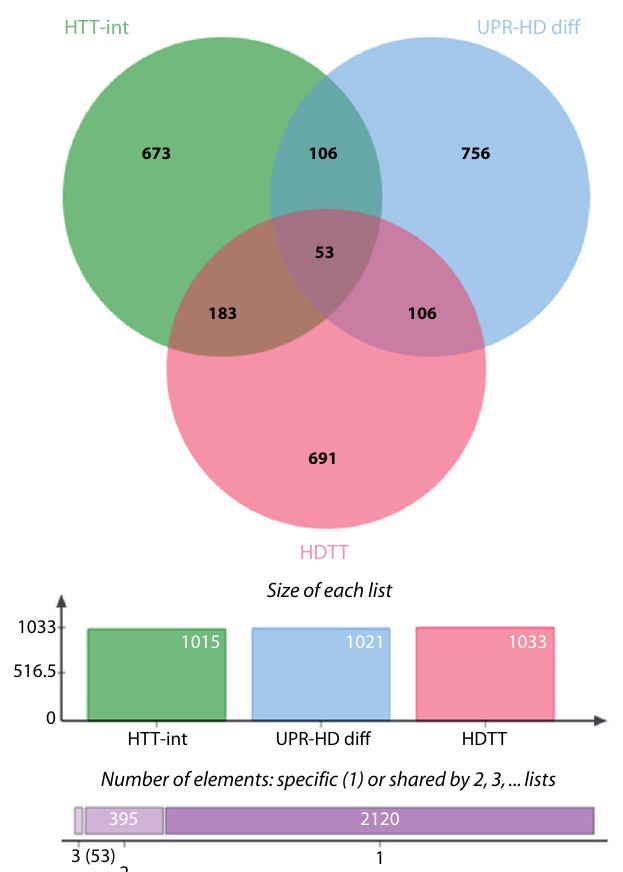
Supplementary Figure 5. UPR-HD connectors for low stringency UPR-HD diff . Venn diagram showing common genes between 3 data sets, low stringency UPR-HD diff : UPR genes that are differentially regulated in HD i.e. either upregulated in human HD iPSC and at least 4 of 6 murine HD models or downregulated in 4 murine HD models; HDTT: HD therapeutic targets as described by Kalathur RK et al. 41 and originated by the HDCrossRoads database; and HTT-D-int: direct HTT interactors derived from the